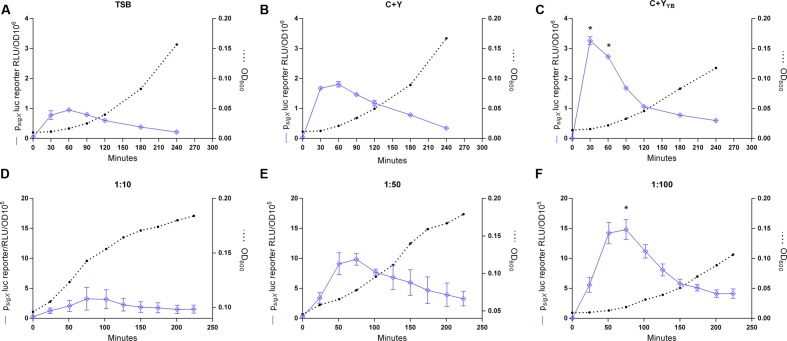
Effect of growth medium and dilution ratios on CSP-induced sigX expression profiles. (A–C) The sigX reporter type strain (MI055; psigX luc) was grown in 200 μL of TSB, C+Y, or C+YY B in a 96-well plate in air at 37°C with 150 nM CSP. ∗ Significant statistical difference in C+YY B when compared to C+Y and TSB (p < 0.05). (D–F) Comparison of sigX expression profiles and culture growth in pre-culture dilution ratios of 1:10, 1:50, or 1:100. Strain MI055 (psigX luc) was grown in 200 μL volumes of C+YY B in a 96-well plate in air at 37°C with 150 nM CSP. ∗ Significant differences on sigX expression comparing 1:10 and 1:50 to 1:100 (p < 0.05). For media comparison, pre-cultures were prepared in TSB and on the day of experiment they were centrifuged and re-suspended 1:100 in fresh medium – TSB, C+Y or C+YY B. For all figures, sigX expression, presented as relative luminescence units (RLU), and culture optical density (OD) were measured periodically. The results are averages from 3 replicates and representative of three independent experiments. Error bars represent standard error of the mean. Differences in sigX expression among media and dilutions rates were analyzed by two-way ANOVA.